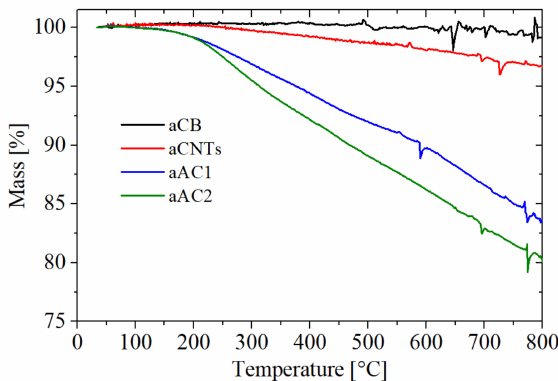
Figure 6. Thermogravimetric Analysis (TGA) under inert conditions (10 K min − 1 ; 20 mL He min − 1 ).